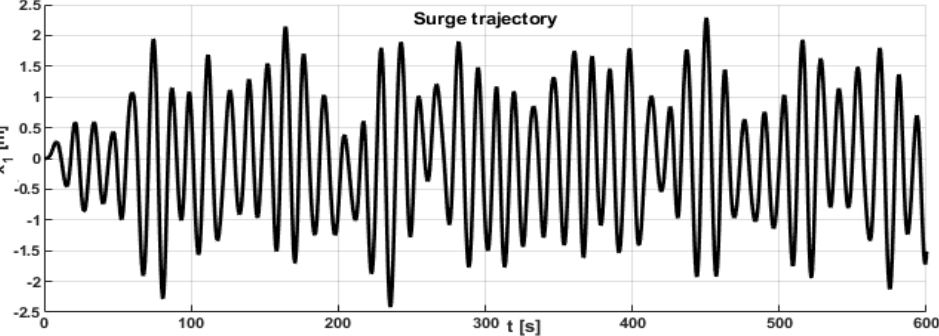
Figure 14. Surge response to IW8 according to weakly nonlinear time − domain solver.